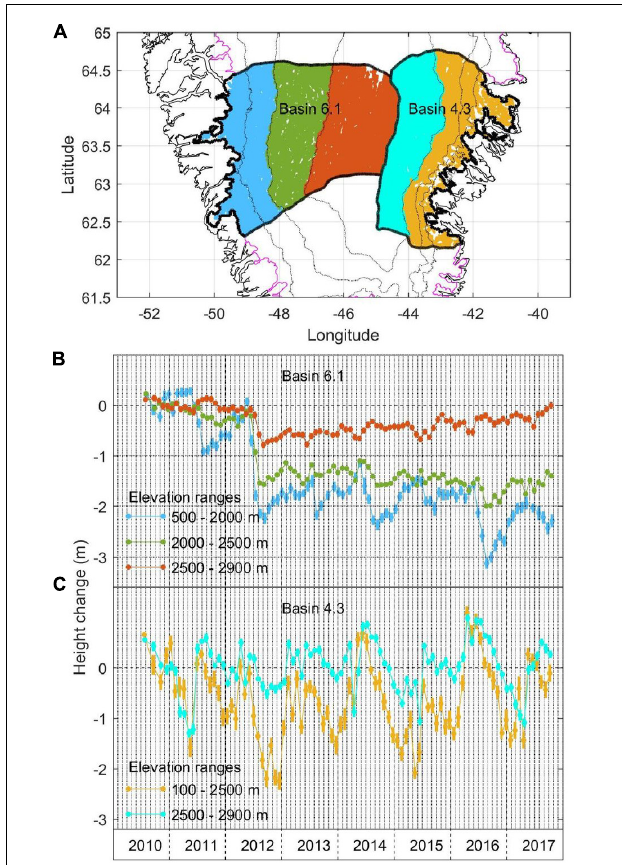
FIGURE 6 | (A) Positions of the CryoSat footprints for three elevation ranges in basin 6.1 (167,792 blue samples, 207,437 green samples, and 211,661 brown samples) and two (125,92 light blue samples and 225,728 fawn samples) in basin 4.3. The 30-day temporal height change in meters with respect to the winter of 2010/11 is shown for the different elevation ranges in basin 6.1 (B) and basin 4.3 (C) .